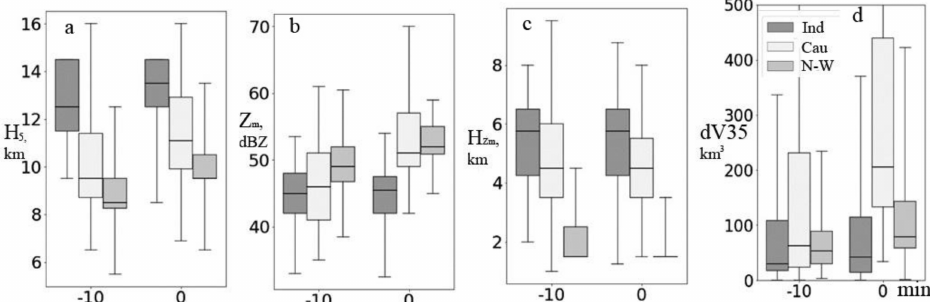
Figure 2. Box-and-whisker diagram of radar characteristics: ( a ) height of the 5 dBZ reflectivity H 5 (km); ( b ) the maximum reflectivity Z m (dBZ); ( c ) the Z m height H Zm (km); ( d ) volume dV35 above the zero-degree isotherm with the reflectivity higher than reflectivity threshold of 35 dBZ. The abscissa axis: two radar scans at the time of a lightning discharge (0 min) and 10 min before the discharge ( − 10 min). A box shows the 25 % and 75% quartiles, the line inside a box is the median, whiskers are the minimum and maximum in a sample. Regions (small box in upper right corner): India (Ind); north Caucasus (Cau); northwestern Russia